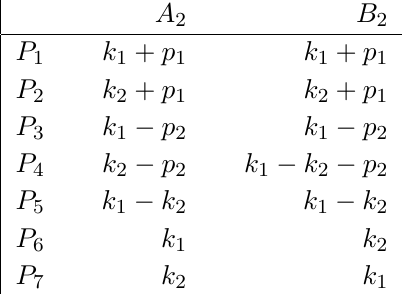
Table 1 . Two-loop auxiliary topologies.